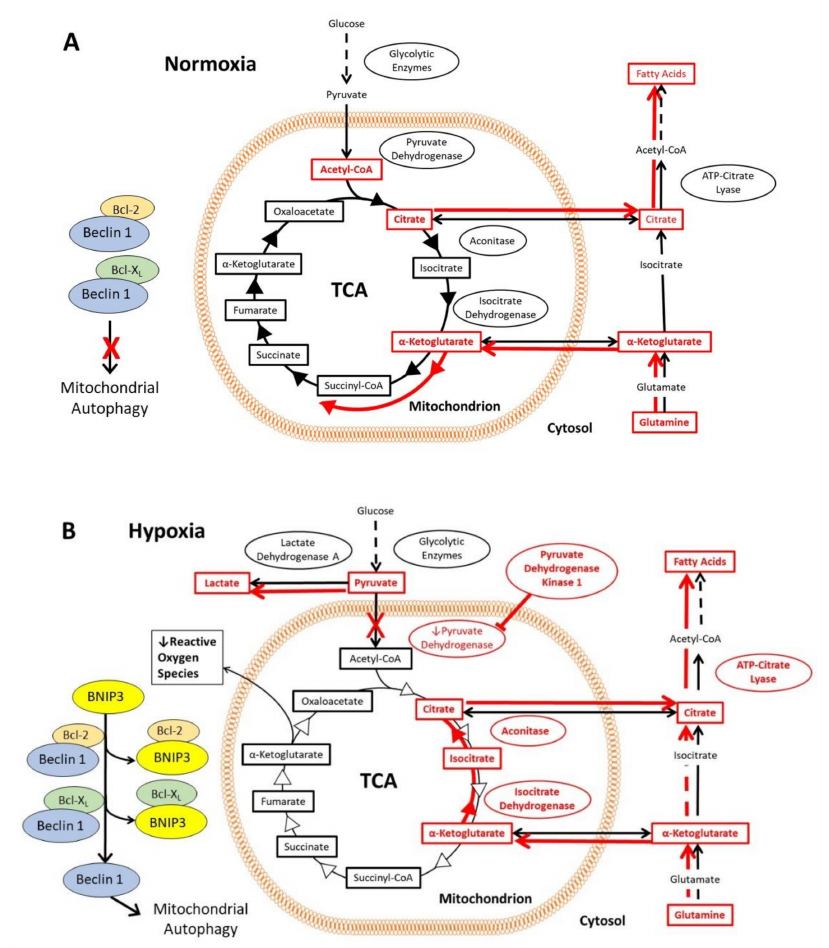
Figure 2. Effects of the HIF-1 activation on the tricarboxylic acid cycle and associated pathways, including glutamine and citrate metabolism, in hypoxia. The mechanisms are highlighted in red, and the red arrows indicate the direction of flux via the metabolic pathways under the prevailing oxygen tension. ( A ) In normoxia, pyruvate produced via glycolysis enters the mitochondria, where it is converted to acetyl-CoA and enters the tri-carboxylic acid cycle (TCA). Citrate from the TCA can be exported from the mitochondria into the cytosol, where it is converted to acetyl-CoA for fatty acid synthesis. Cytosolic glutamine is converted to α -ketoglutarate and transported into the mitochondria where it enters the TCA. A key regulator of autophagy, Beclin 1 is inhibited by Bcl-2 and Bcl-XL, thereby decreasing autophagy. ( B ) In hypoxia, HIF-1 activation results in increased flux through the glycolytic pathway, as well as accumulation of pyruvate and conversion into lactate. BNIP3 and BNIP3L (not shown in this figure) are expressed under the control of HIF-1, which then interact with Bcl-2 and Bcl-XL to liberate Beclin 1. Beclin 1 induces mitochondrial autophagy, reducing the formation of mitochondrial reactive oxygen species under hypoxia. Fatty acid synthesis is maintained by reductive carboxylation of glutamine, formation of citrate, and conversion of citrate into acetyl-CoA in the